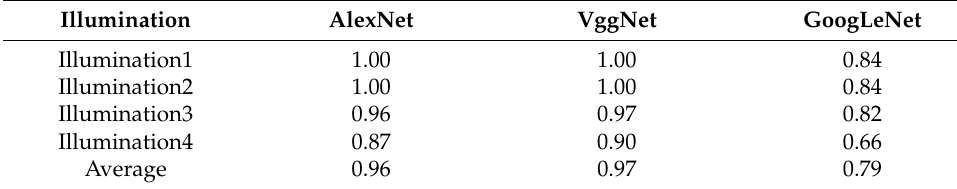
Figure 26. The P-R curve of GoogLeNet under different illuminations. Table 3. AUC comparison under different